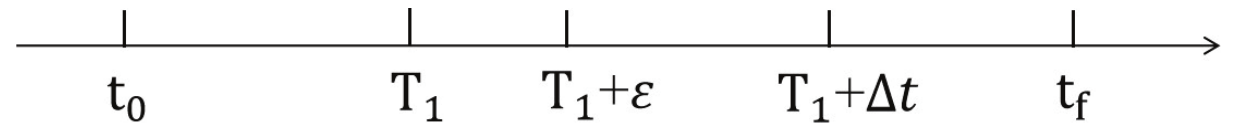
Figure 1. Switching times within the time